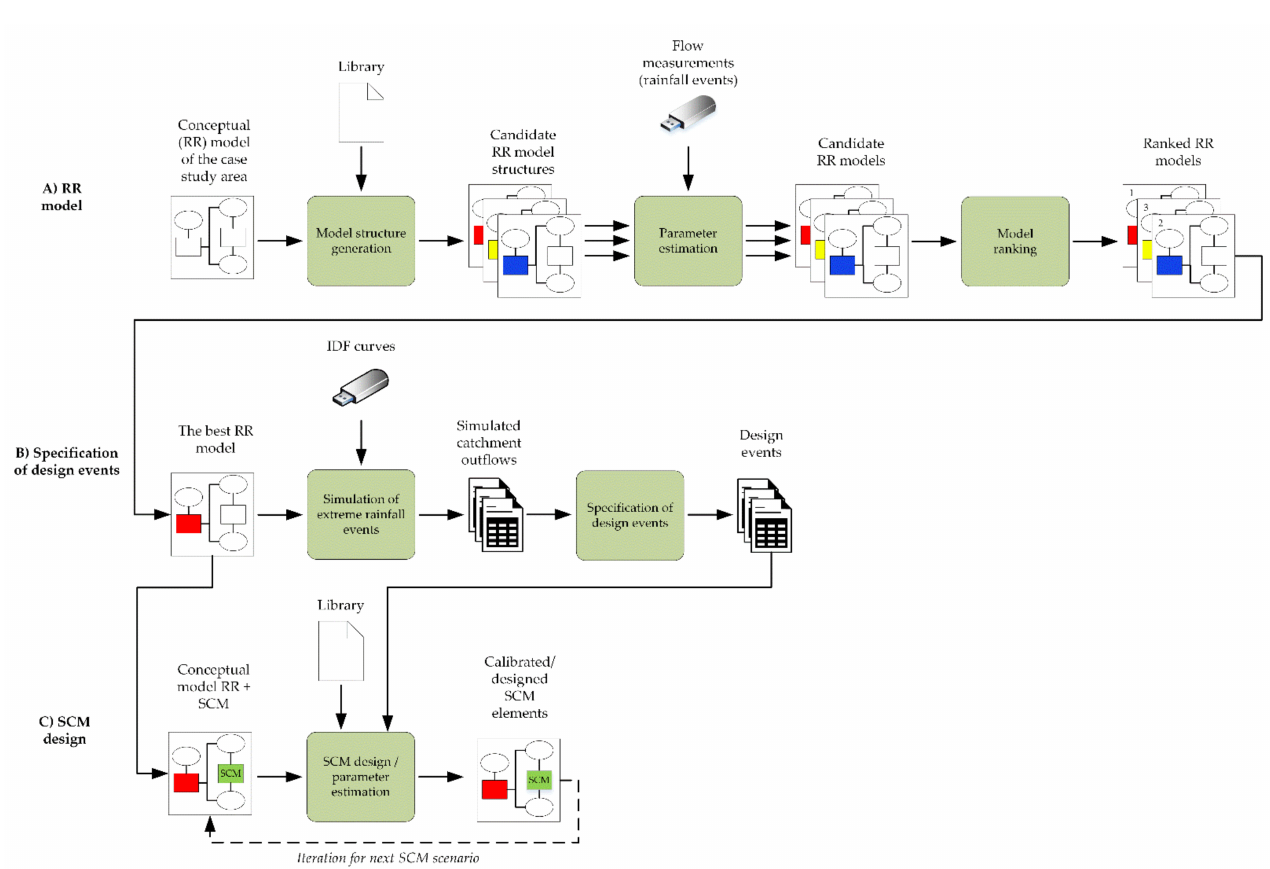
Figure 3. A schematic workflow for the rainfall-runoff (RR) model discovery and stormwater control measure (SCM) design using the automated modeling tool